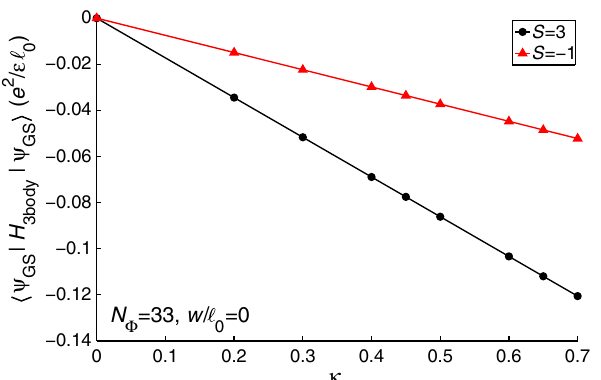
FIG. 1. Expectation value of the three-body terms in the j H j Ψ i in the S ¼ 3 (MR) and Hamiltonian h Ψ 3 body GS GS S ¼ − 1 (aPf) ground states obtained at κ ¼ 0 and w= l ¼ 0 in 0 the system with N Φ ¼ 33 in the spherical geometry. Here, H 3 body is the second term in Eq. (2) and introduces κ dependence. H 3 body is the lowest-order perturbative contribution to the energies of these states. The energy of the S ¼ 3 (MR) state is lowered